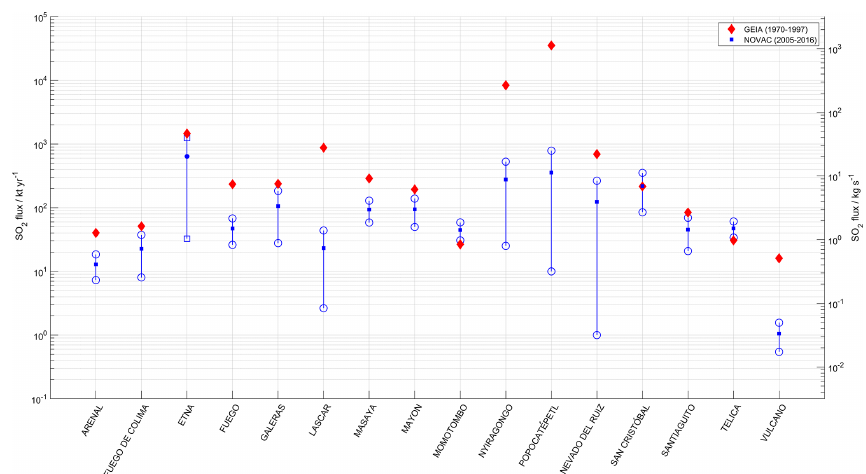
Figure 6. Comparison of emission statistics for 16 volcanoes of the NOVAC and GEIA datasets. For NOVAC the simple averages of the annual mean (filled blue dots) and ± 1 standard deviations (un-filled blue dots) for the years 2005–2016 are depicted. The values for GEIA are obtained from Andres and Kasgnoc (1998) for passively degassing and sporadically degassing volcanoes